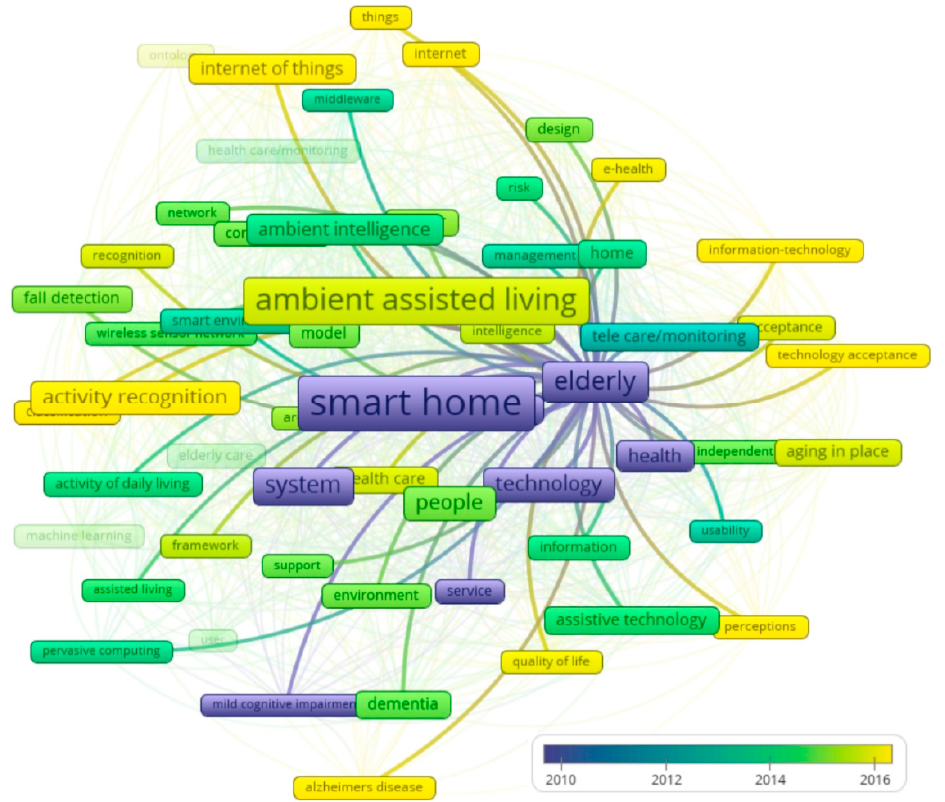
Figure 7. Clustering the keywords from ISI WOK records for the “Smart Furniture” phrase in Topic in recent years (2010–2016) and coloured progress of used keywords.